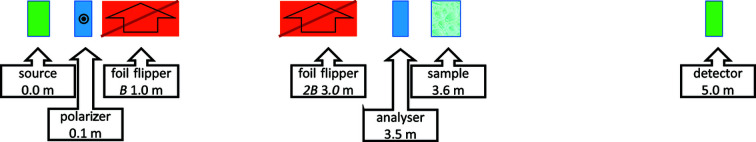
Schematic drawing of the McStas SEMSANS setup. Distances, sizes and angles are not to scale. The polarizer sets the neutron polarization out of the plane of the drawing. The magnetic field surrounding the second foil flipper is twice as strong as the corresponding field surrounding the first foil flipper.